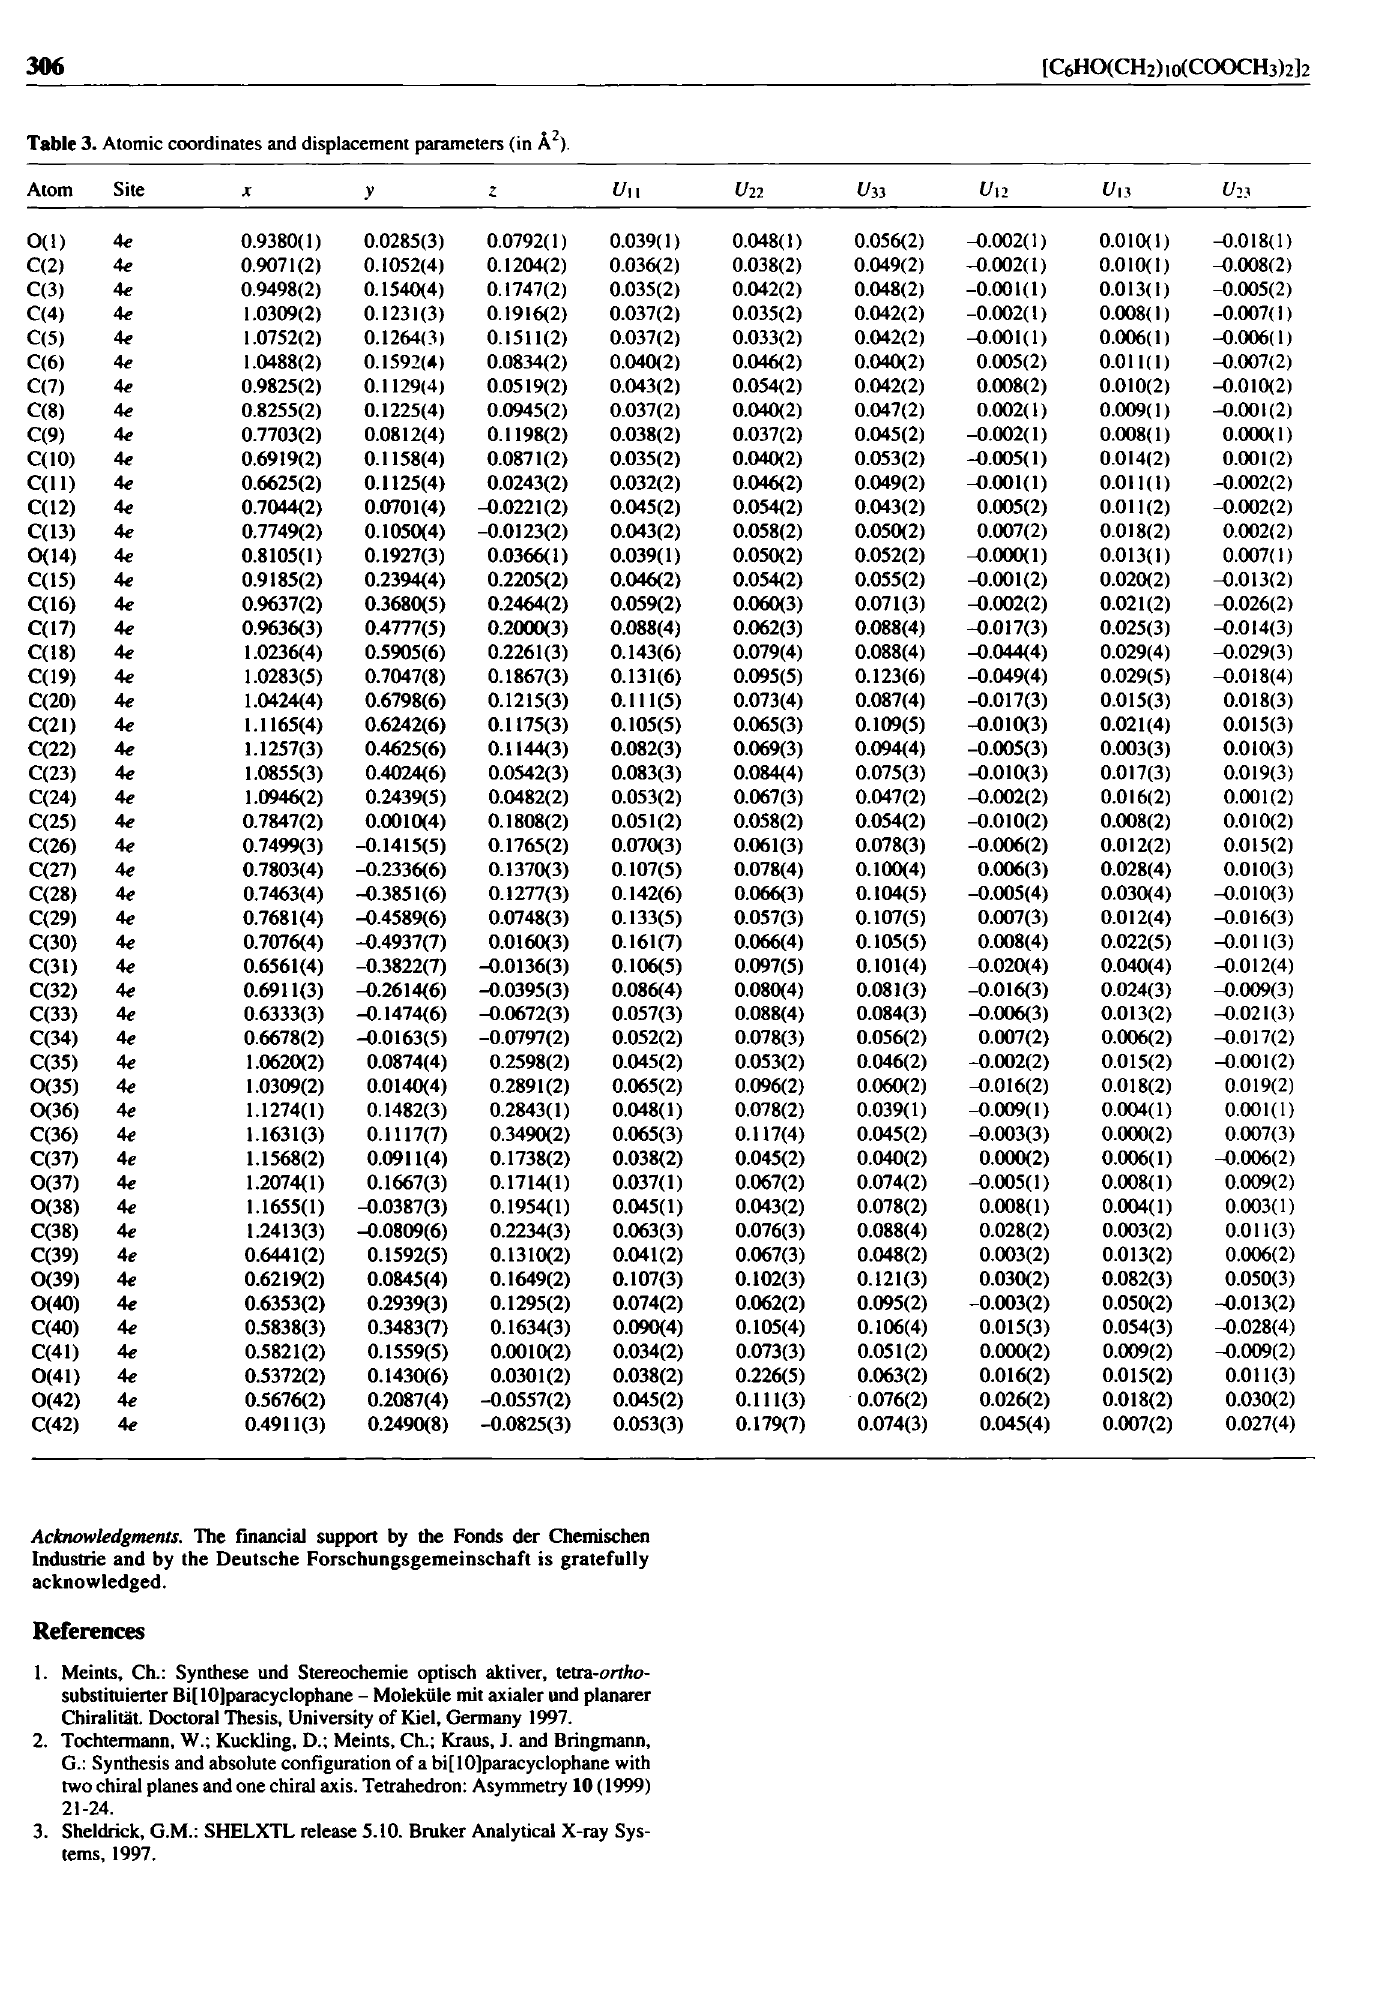
Table 3. Atomic coordinates and displacement parameters (in A 2